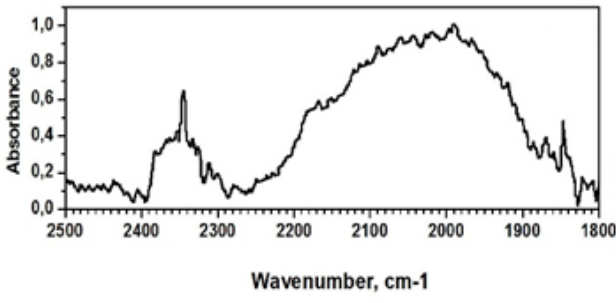
Fig. 4. FTIR (Fourier-transform infrared) spectra of the MoN film in the 1800-2500 cm −1 spectral